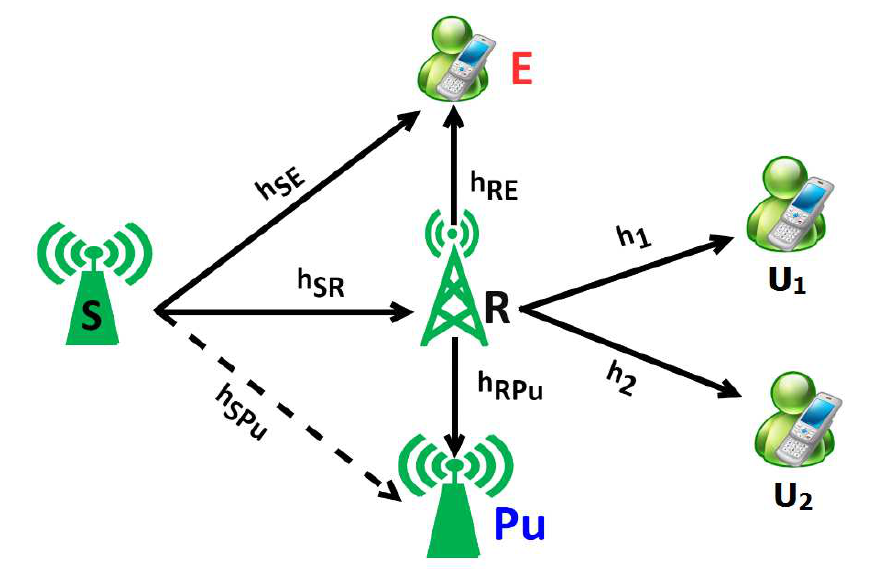
Figure 1. System model of NOMA and PLS under imperfect CSI in a